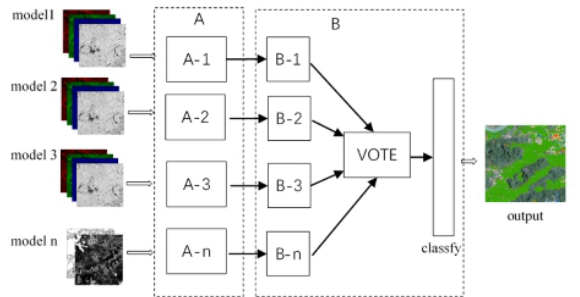
Fig. 3 Structure of the Multi-model Integration Classification